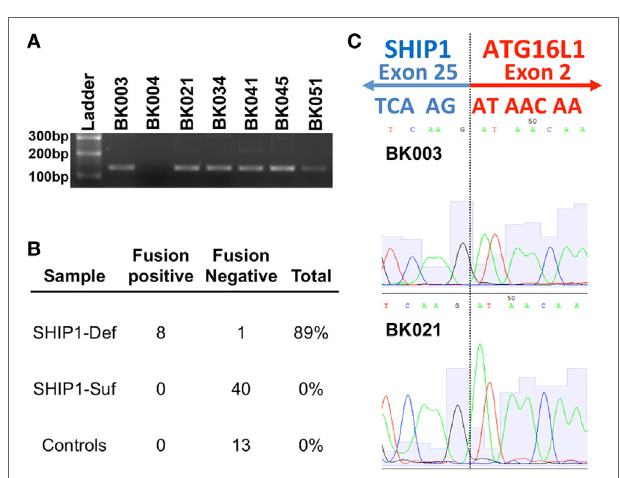
FigUre 4 | RNA-sequencing (RNA-Seq) analysis uncovered a novel fusion mRNA transcript that links SHIP1 exon 25 to ATG16L1 exon 2 in SHIP1- deficient subjects. (a) RNA-Seq analysis revealed the presence of a fusion transcript between SHIP1 and downstream ATG16L1 in 8 of 8 SHIP1- deficient subjects but not in either 2/2 of the SHIP1-sufficient patient analyzed in the same analysis. RT-PCR analysis using primers specifically targeting the fusion transcript was used to screen a subset of the inflammatory bowel disease (IBD) cohort, which confirmed the presence of this fusion transcript in 8/9 SHIP1-deficient patients. (B) Fusion transcript was not observed in 53 of the SHIP1-sufficient and healthy control subjects, while it was observed in 89% of SHIP1-deficient samples (8 of 9). This represents a highly significant association to the SHIP1-deficient phenotype with an odds ratio (OR) of 153.0 (95% CI: 5.562–4,209, P < 0.0001) compared to the 13 controls, and an OR of 606.3 (95% CI: 22.76–16,150, P < 0.0001) compared to all